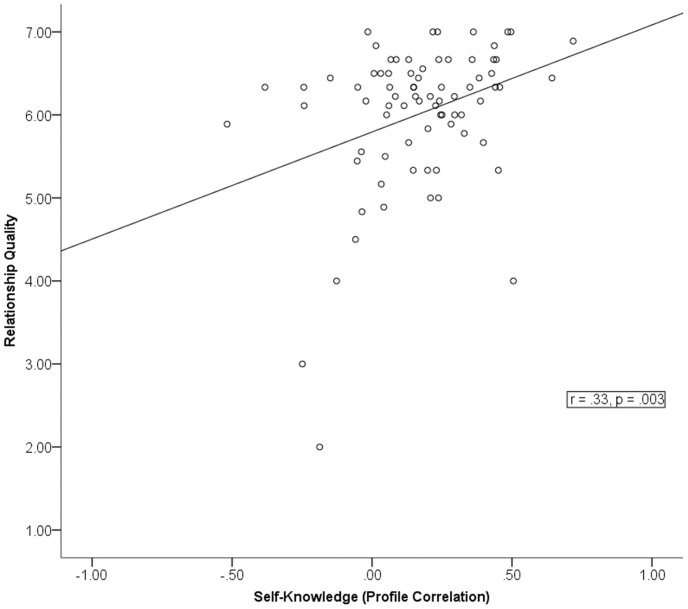
Relationship quality as a function of participants’ degree of self-knowledge (N = 77).
Figure 1 shows the association between individual differences in self-knowledge and informant-rated relationship quality. Self-knowledge was operationalized as how well participants knew how they typically behaved in daily life compared to others. In order to compute a self-knowledge score for each participant, we calculated each participant’s profile correlation between self-ratings of daily behavior (on the ACT questionnaire) and behavioral codings of actual daily behavior (from the EAR sound recordings) across 17 items. Relationship quality was the mean of informants’ ratings of relationship quality, closeness, and liking.